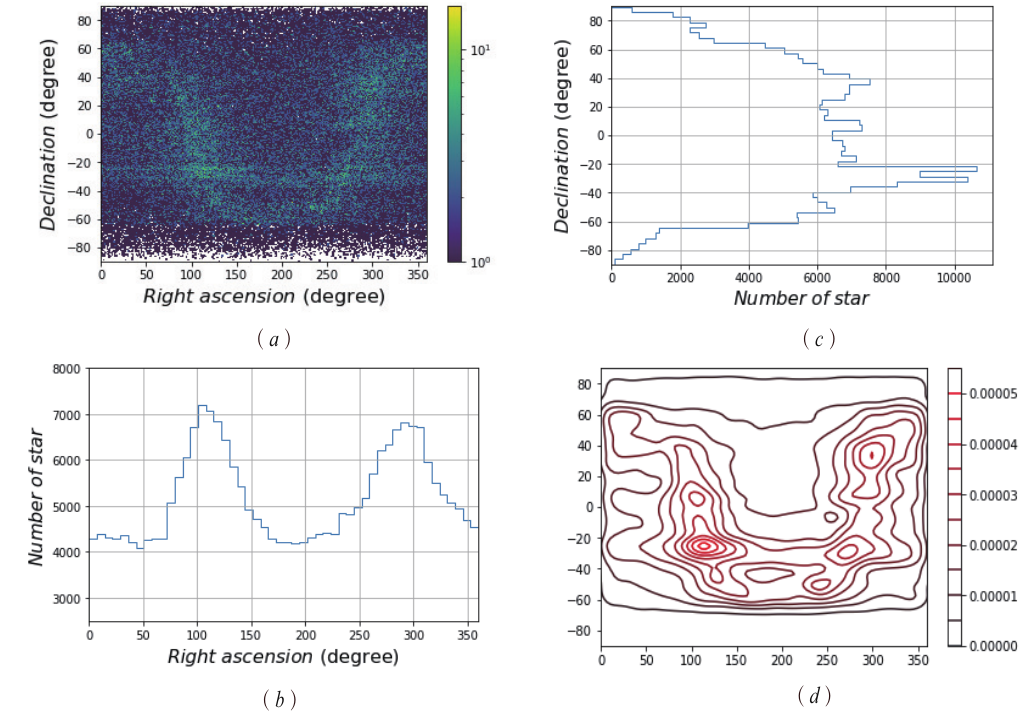
Figure 4. The scattered data density of the SA0 star catalogue. ( a ) The distribution density of SAO GSC; ( b ) the statistics of the NOS distributed in the direction of right ascension; ( c ) the statistics of the NOS distributed in the direction of declination; ( d ) the nuclear density line of SAO GSC stars in the celestial sphere.